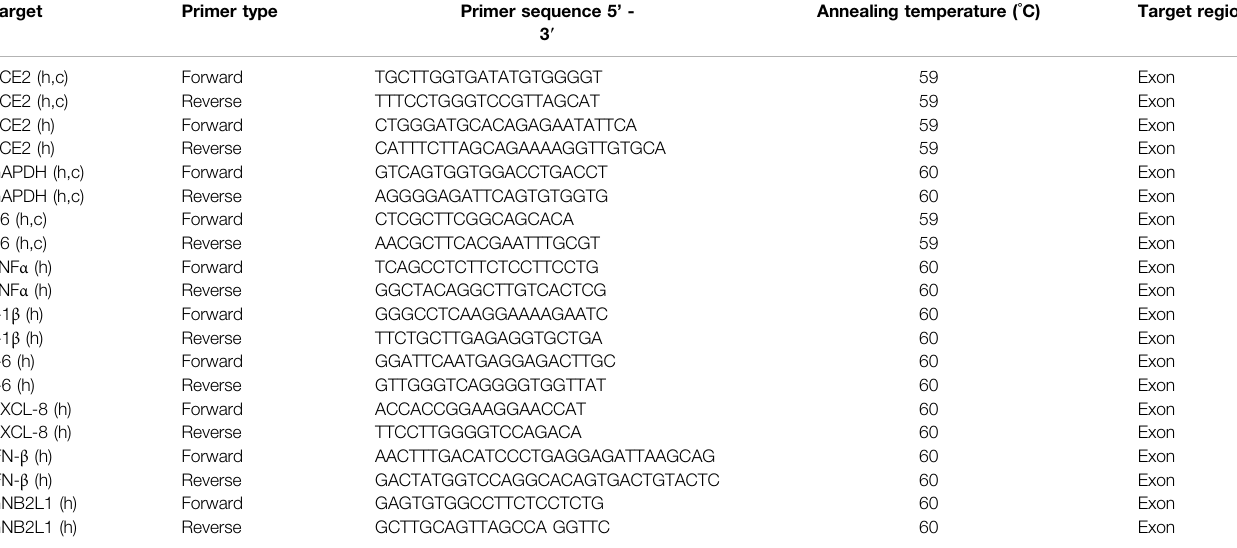
TABLE 2 | qPCR primers. Primers were designed using primer3 and ordered by MWG Euro fi ns. Species speci fi city of oligos: Homo sapiens (h), Chlorocebus aethiops